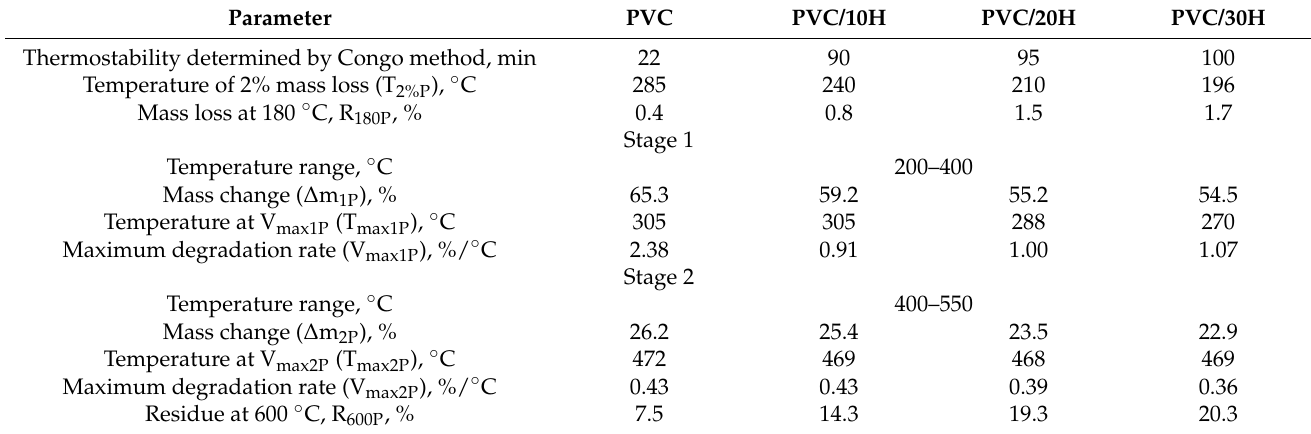
Table 4. The results of thermostability analysis by Congo and analysis of TG and DTG curves of poly(vinyl chloride) and PVC composites.